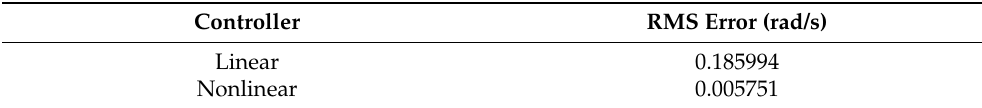
Figure 7. Rotational speed error for linear controller ( a ) and nonlinear controller ( b ). Table 5. RMS speed control errors for linear and nonlinear controllers. Table 5. RMS speed control errors for linear and nonlinear controllers.